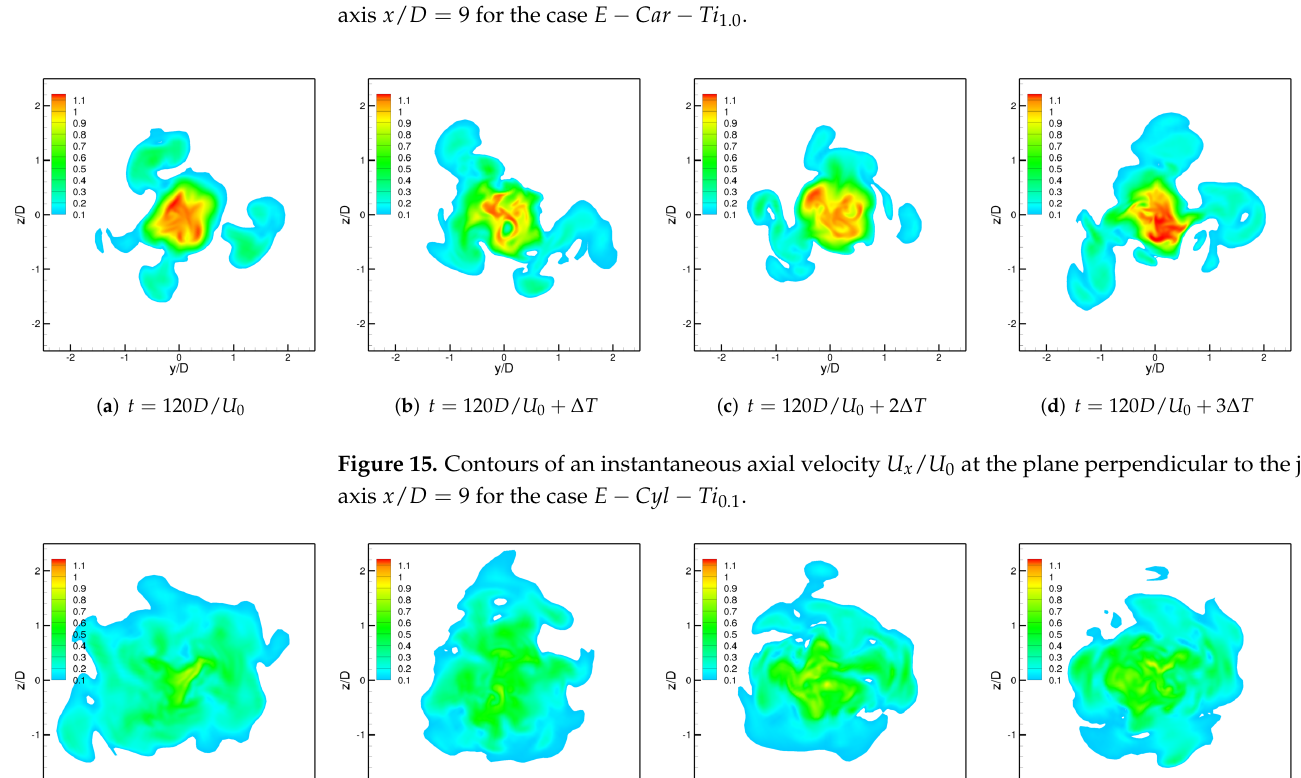
Figure 14. Contours of an instantaneous axial velocity U x / U 0 at the plane perpendicular to the jet axis x / D = 9 for the case E − Car − Ti 1.0 .